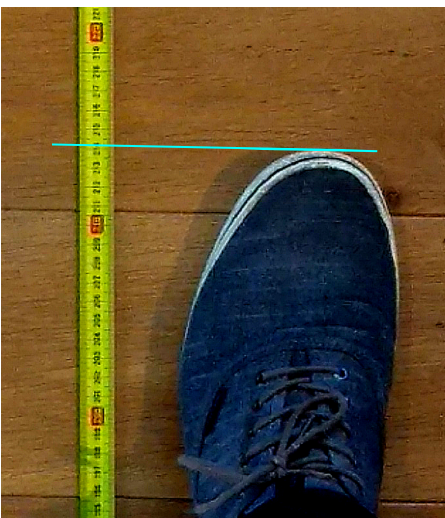
Figure 5. Example of how position of tip of foot is determined relative to tape measure from the camera